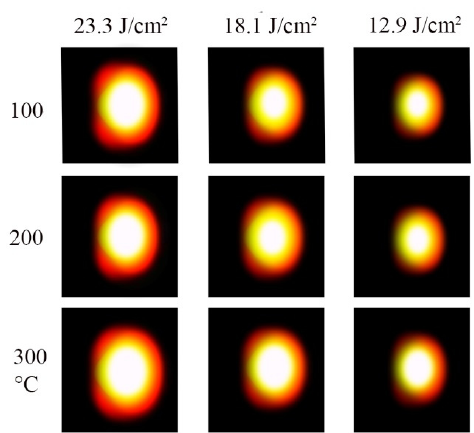
Figure 7. Images of the plasma plume at different laser fluences and different sample temperatures.